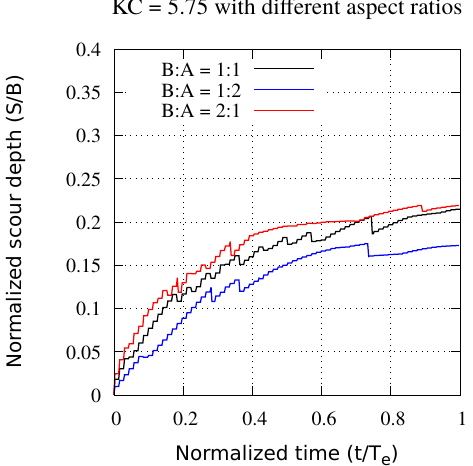
Figure 9. Temporal variations of normalized scour depth versus normalized time for KC = 5.75 for combined wave current parameter ( U cw ) of 0.4. The wave period (T) is 4.5